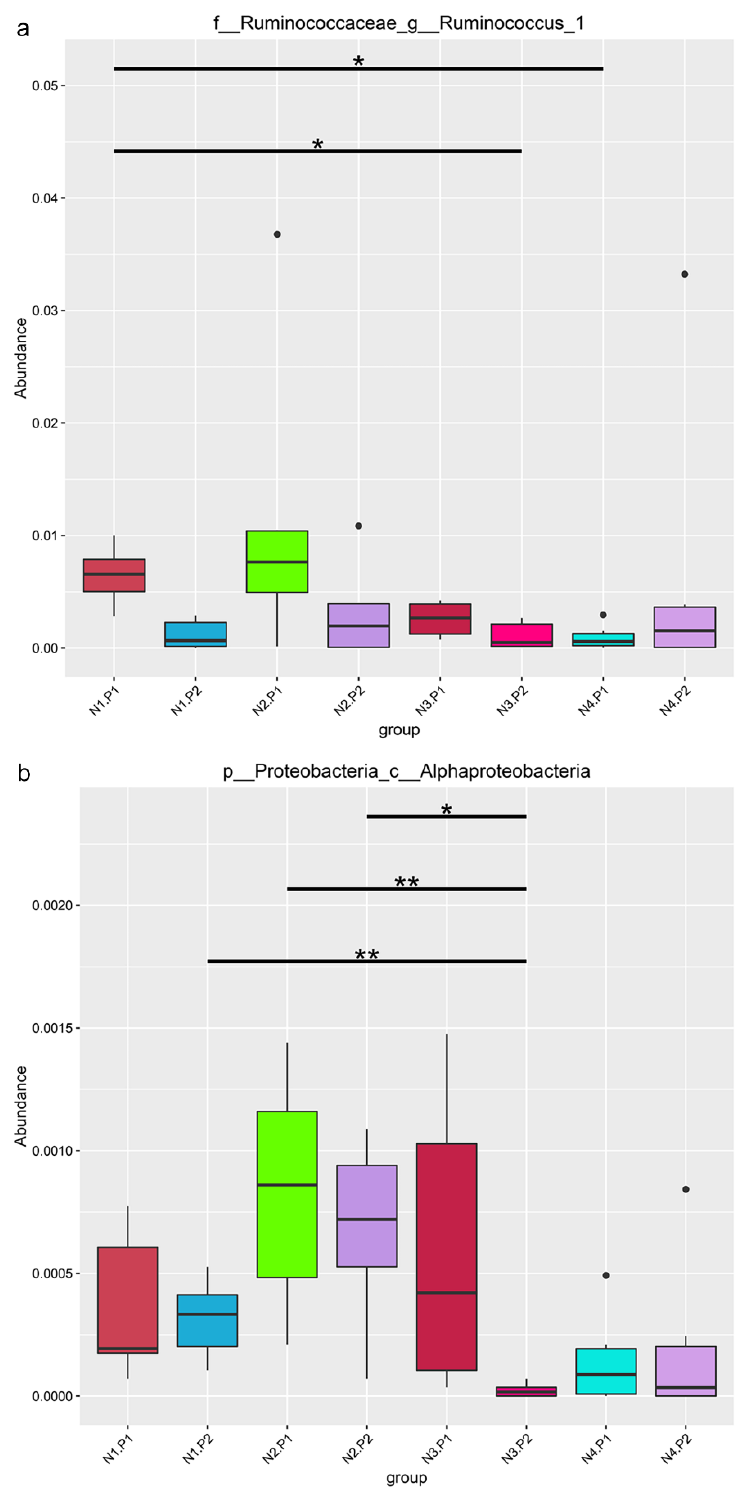
Figure 6. Analysis of significant differences between groups in metastats. ( a ), family_ Ruminococcaceae _genus_ Ruminococcus _1; ( b ), phylum_ Proteobacteria _class_ Alphaproteobacteria . P1: the experimental period is 7 days. P2: the experimental period is 14 days. N1: 22.5 mg/kg niacin group. N2: 30 mg/kg niacin group. N3: 45 mg/kg niacin group. N4: 75 mg/kg niacin group. Black pots: abnormal value. *: p < 0.05; **: p < 0.01.